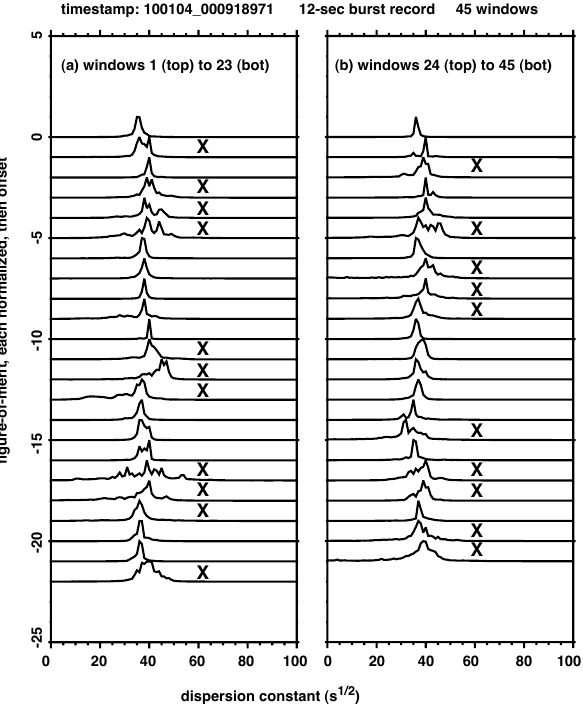
Fig. 5. Preliminary figure-of-merit vs. dispersion constant, for all 45 analysis windows within the burst recording of Fig. 1. Curves for successive windows are displaced downward in each column. Any window marked “X” fails the figure-of-merit